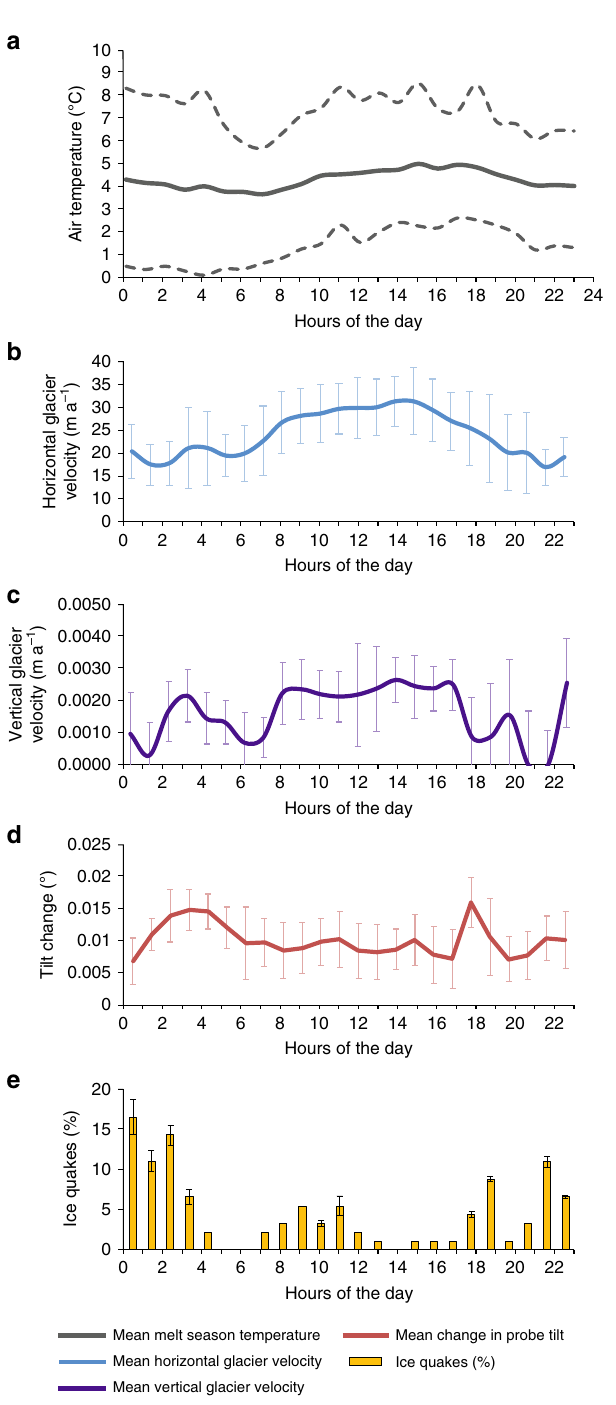
Fig. 5 Graphs showing mean melt season diurnal data (2012): a air temperature (mean shown as a solid line, the 10% warmest and 10% coolest days are shown as a dashed line); b horizontal glacier velocity; c vertical glacier velocity; d probe tilt change; e Icequakes (plotted as an hourly percentage) (error bars are proportional to one standard